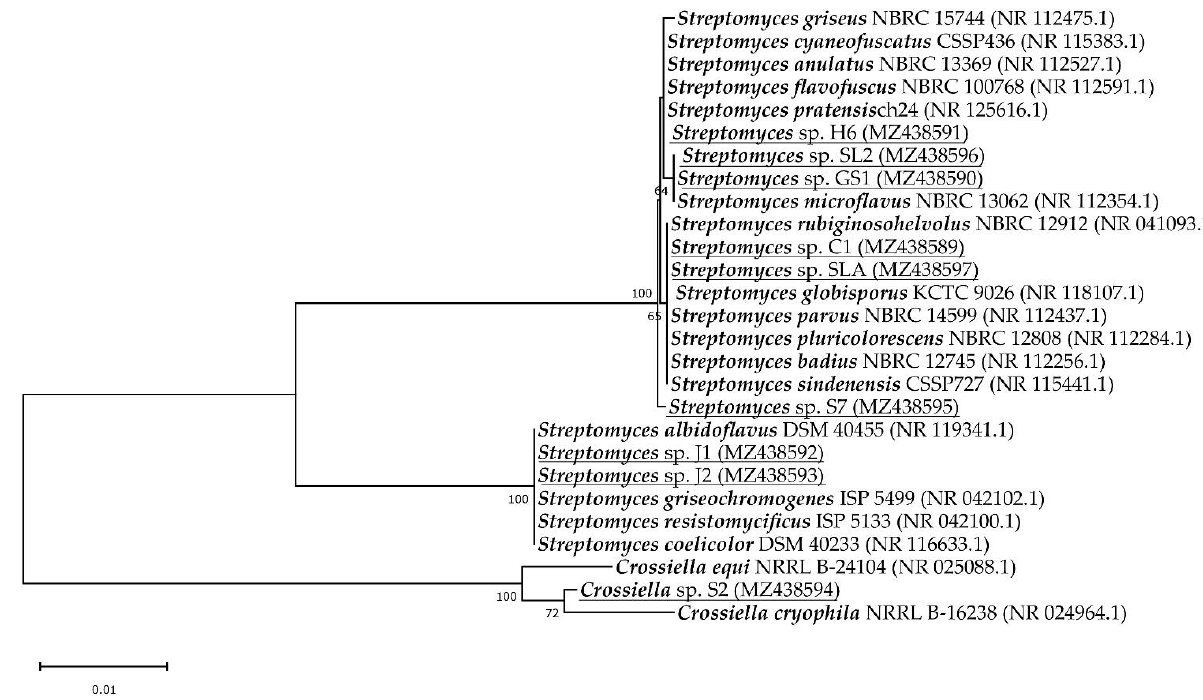
Figure 1. The phylogenetic tree based on the 16S rRNA gene sequences. The evolutionary history was inferred using the neighbor-joining method [39]. The optimal tree with the sum of branch length = 0.13126272 is shown. The percentage of replicate trees in which the associated taxa clustered together in the bootstrap test (1000 replicates) are shown next to the branches [40]. The tree is drawn to scale, with branch lengths in the same units as those of the evolutionary distances used to infer the phylogenetic tree. The evolutionary distances were computed using the Kimura 2-parameter method [41] and are in units of the number of base substitutions per site. The analysis involved 27 nucleotide sequences, the isolates included in this study are underlined. All ambiguous positions were removed for each sequence pair (pairwise deletion option). There was a total of 1274 positions in the final dataset. Evolutionary analyses were conducted in MEGA X [29].